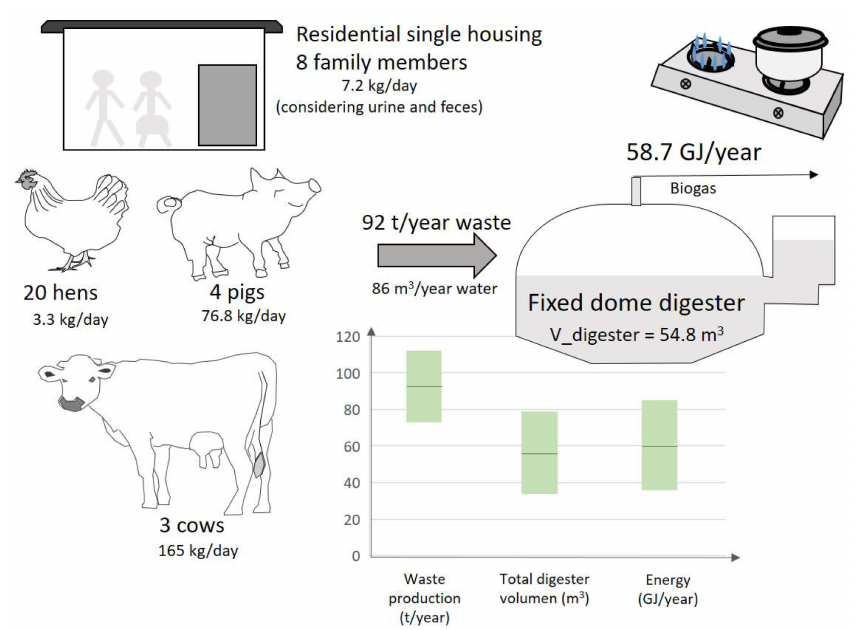
Figure 5. Results obtained from Scenario 3, evaluating single housing in developing countries under mild climatic